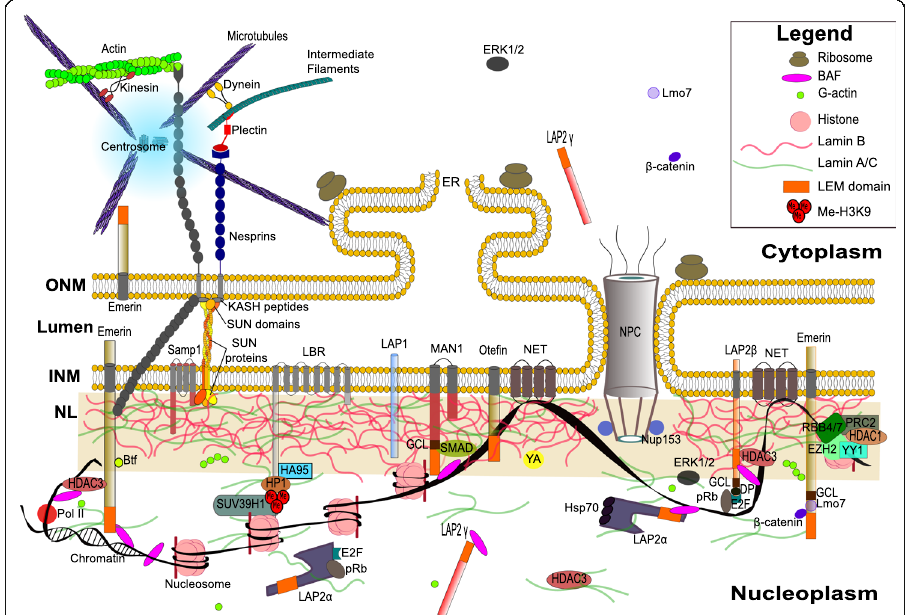
Fig. 1 A simplified diagram of the interaction between the protein components of the nuclear lamina and the nuclear envelope with chromatin and the cytoskeleton. Only well documented proteins with high importance for biological functions are demonstrated. Please note that we included two fly-specific proteins (YA and otefin) along with the typical vertebrate proteins. ONM – outer nuclear membrane; INM – inner nuclear membrane; NL – nuclear lamina; NET – nuclear envelope transmembrane proteins; LBR – lamin B receptor; NPC – nuclear pore